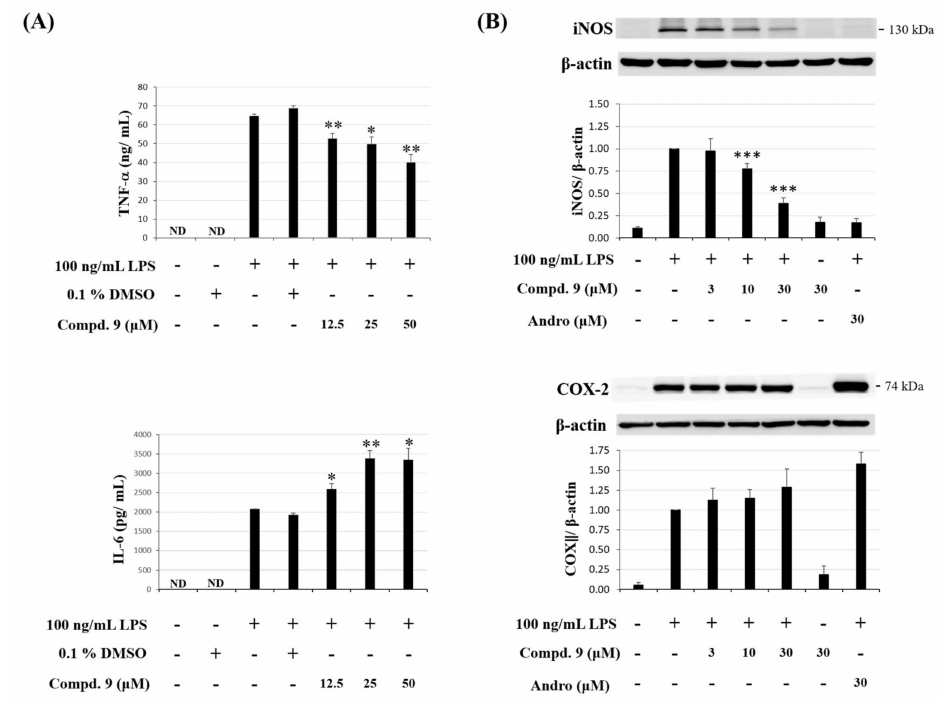
Figure 9. E ff ect of otogirinin A ( 9 ) on proinflammatory mediator expression in LPS-induced RAW264.7 macrophages. ( A ) Expression levels of TNF- α and IL-6 determined by ELISA. Data expressed as means ± SEM (n = 3). Asterisks indicate significant di ff erences (* p < 0.05 and ** p < 0.01) from the (media + DMSO + LPS) control group; ( B ) expression of iNOS and COX2 was determined by Western blot analysis. Data expressed as means ± SEM (n = 3). Asterisks indicate significant di ff erences (*** p < 0.001) from the (media + LPS) control